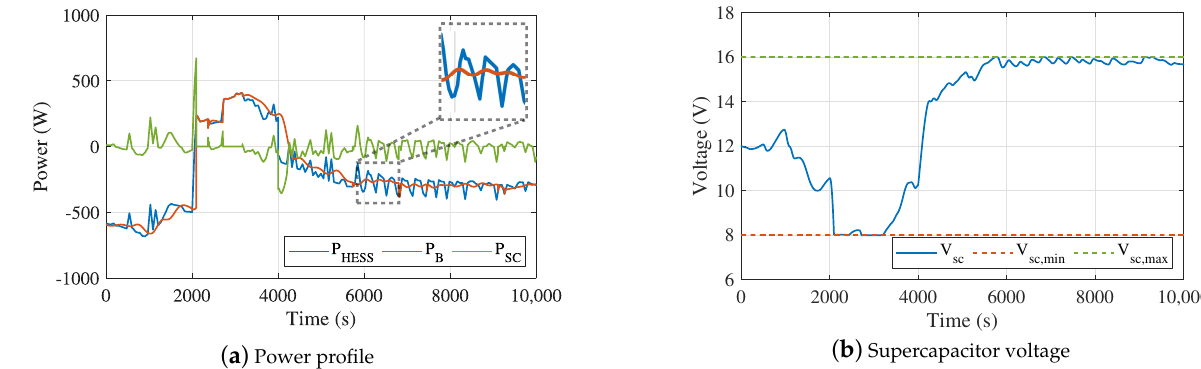
Figure 6. Power filtering and voltage results for the HESS with a finite impulse response (FIR) filter ( N = 420 and ω c = 0.0005 π